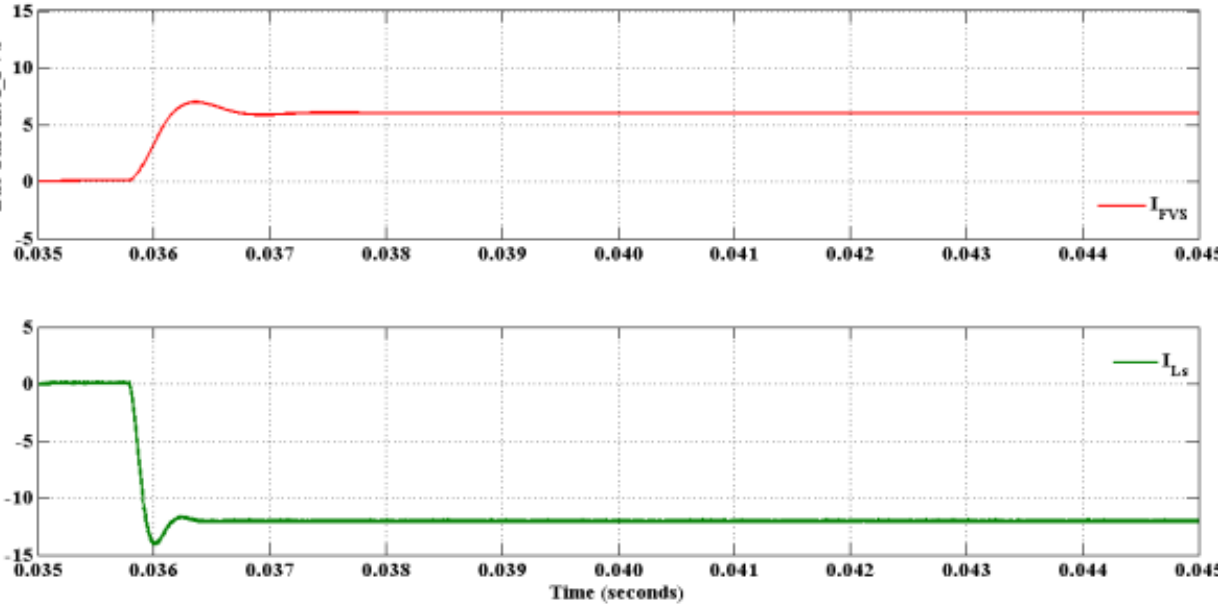
Figure 20. Regulated current step variations in inductor currents at buck mode.